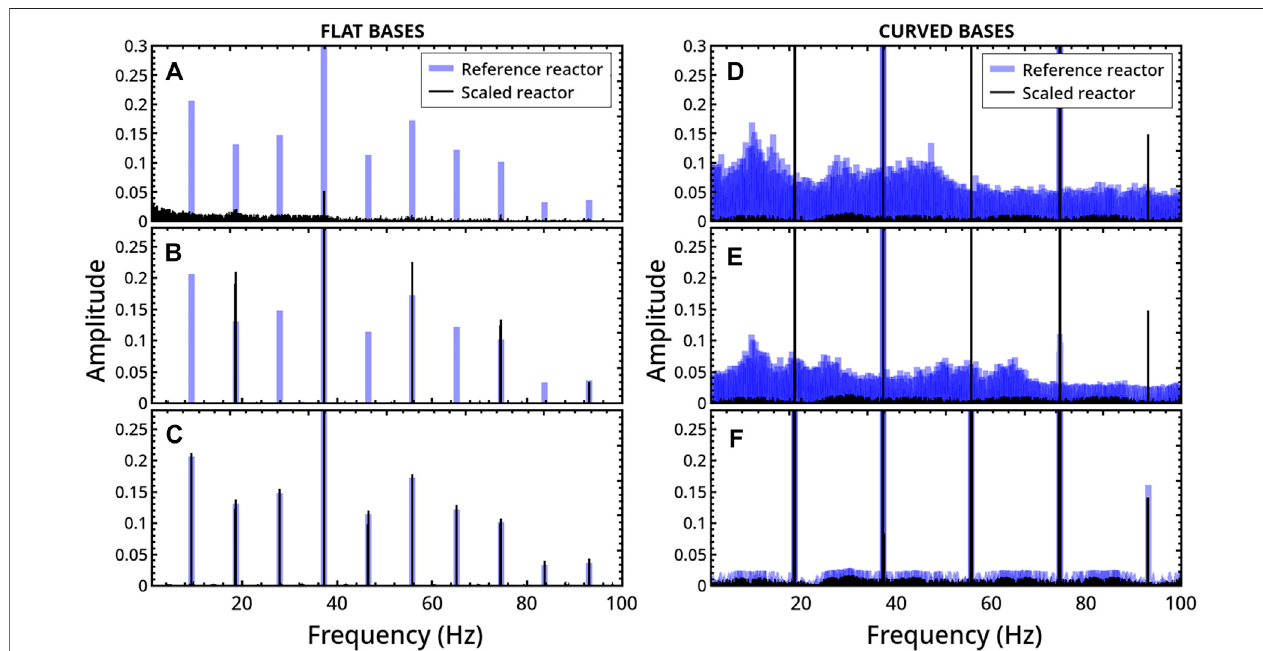
FIGURE 7 | Comparison between the milling disc dynamics obtained by changing the reactor size with the milling disc radius in fl at-base (left) and curved-base (right) geometries, keeping fi xed the ratio Q (cid:1) Ω c / ( π ( r d ) 2 ) (cid:1) Ω c / ( π ( r d ) 2 ) ( f = 0.5). The reference systems, in blue, are characterized by r 1 d (cid:1) 3 mm, Ω 1 f (cid:1) 53 mm × 18.8 mm = Ω 1 c (cid:1) 38.2 mm × 18.8 mm + π (9.4 mm) 2 while the scaled reactors, in black, have r 2 d (cid:1) 1 . 5 r 1 d (cid:1) 4.5 mm, Ω 2 f (cid:1) Ω 2 c (cid:1) 2 . 25 Ω 1 f (cid:1) 2 . 25 Ω 1 c . The comparison betweenthereferenceand scaled systemsisperformed byusingtheFastFourier Transforms ofthe z -displacementofthemilling discover time.Thechangeofthe reactor size is operated in three different ways: (A – D) Case 1: scaling the dimensions without preserving the reactor aspect ratio keeping R = 122 mm ( Ω 2 f (cid:1) 53 mm × 42.3 mm; Ω 2 c (cid:1) 104.4 mm×18.8 mm+ π (9.4 mm) 2 ); (B – E) case2:scalingthedimensionsbythesamefactorofthediscradius,preservingtheaspectratioofthereactor and keeping R = 122 mm ( Ω 2 f (cid:1) 79.45 mm × 28.2 mm; Ω 2 c (cid:1) 57.3 mm × 28.2 mm + π (14.1 mm) 2 ); (C-F) case 3: scaling the whole system proportionally, including